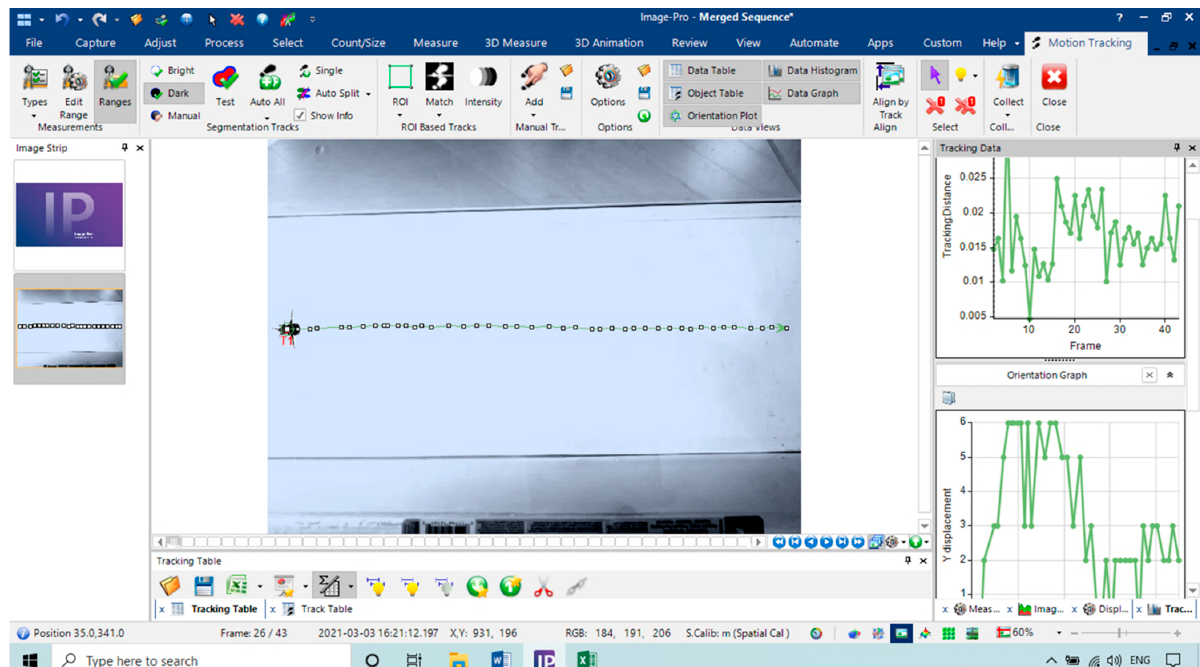
Figure 19. The main window of the Image-Pro program (Image-Pro Plus, Version 10.0.8 for Windows 10).